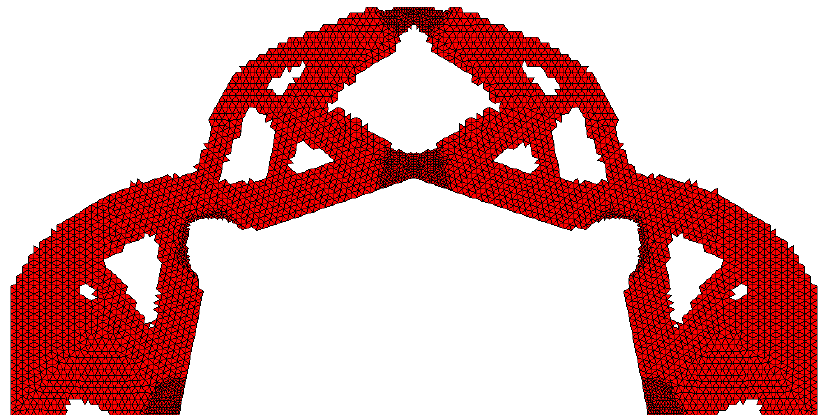
Figure 26. The final topology found for the portal frame.